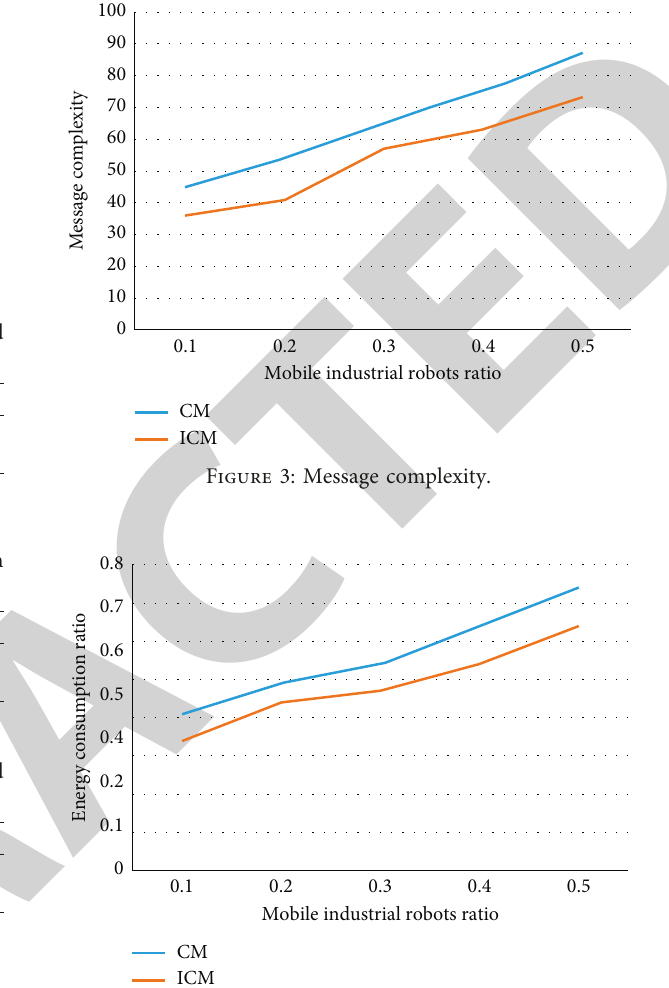
Figure 4: Energy consumption